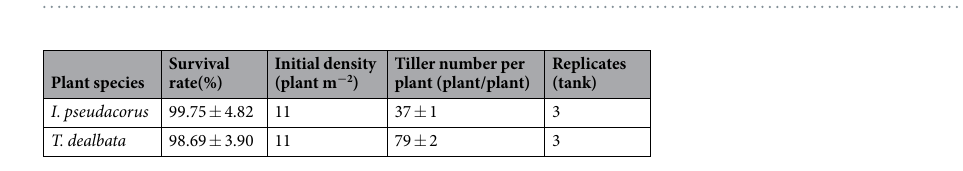
Table 4. Growing state of the tested plants (mean ± SD, n = 3) in current